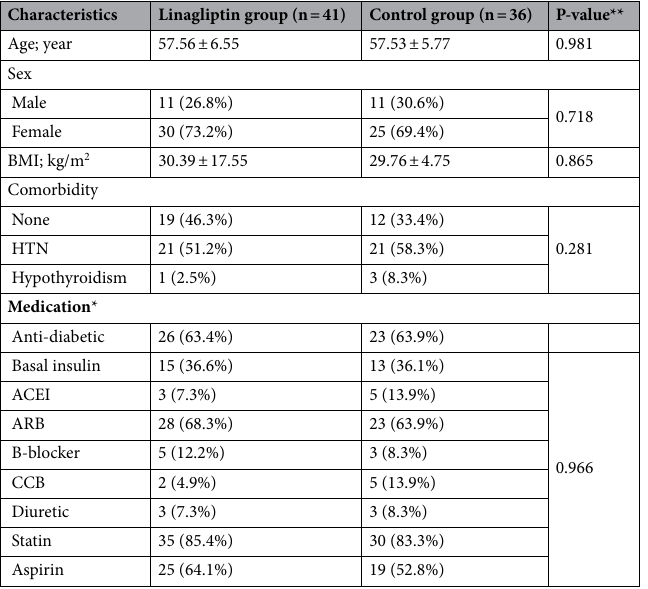
Table 1. Patients’ basic characteristics in the two groups. Data are shown as n (%) or mean ± SD for categorical and continuous variables, respectively. ACEI angiotensin-converting enzyme inhibitors, ARB angiotensin receptor blockers, CCB calcium channel blockers. *Each patient might take more than one drug. **Resulted from independent samples t-test for continuous and chi-squared test for categorical variables.